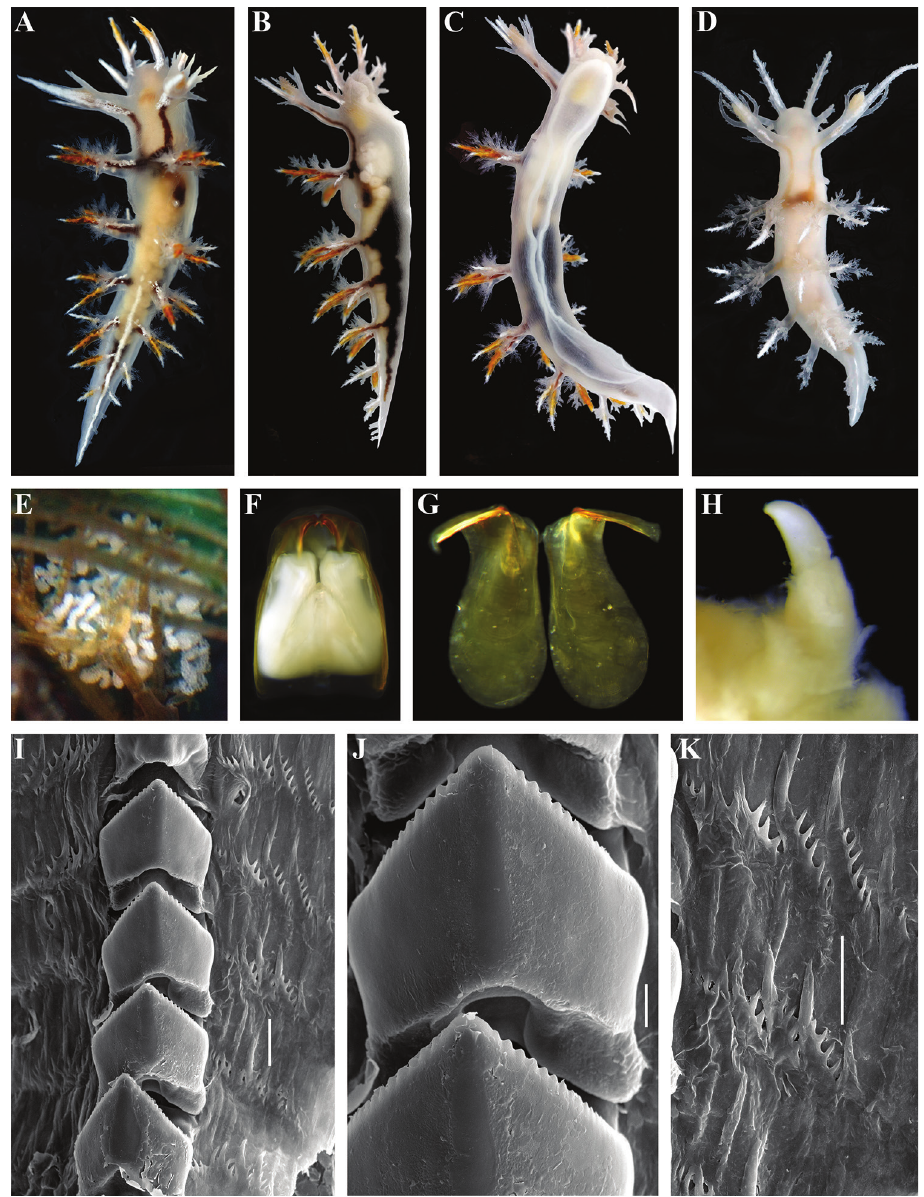
Figure 2. Dendronotus robilliardi sp. n.: A holotype ZMMU Op-568, live, dorsal view B same, lateral view C same, ventral view D paratype ZMMU Op-569, live, dorsal view E egg mass in situ , same col- lection data as holotype F paratype ZMMU Op-567, jaws and radula in situ , dorsal view G same, jaws, lateral views H same, penis I same, posterior rows of radula, SEM J same, details of central teeth, SEM K same, details of lateral teeth, SEM. Scale bars I, K = 30 µm J = 10 µm. Photos of living specimens by Nadezhda Sanamyan, other photos and SEM images by Alexander